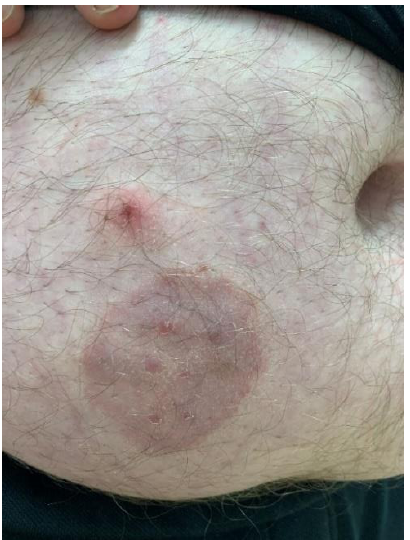
Figure 3. A round lesion on the belly of a male guinea pig owner.